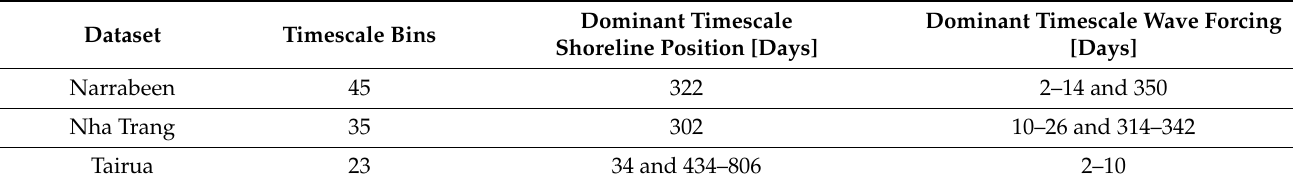
Table 2. Information of the Narrabeen, Nha Trang and Tairua dataset. Dominant timescales are defined as local maximums in the temporal spectra (see Appendix